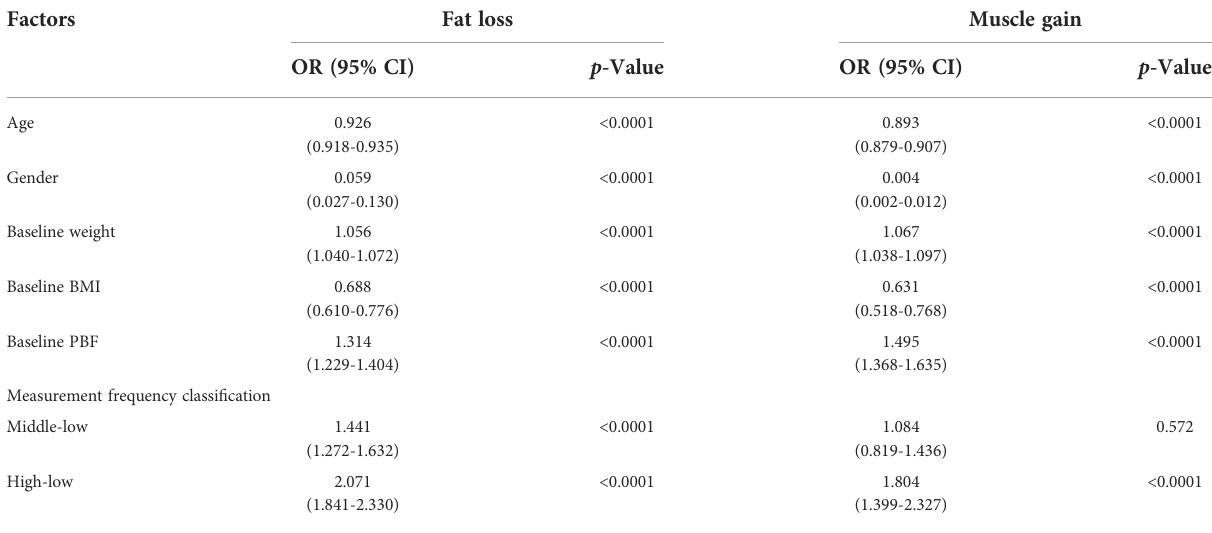
TABLE 4 Factors associated with the effective fat loss and muscle gain in participants with normal BMI but high PBF.